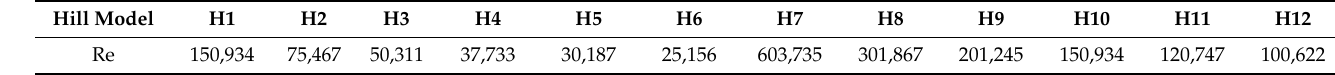
Table 3. Reynolds numbers for hill models ( V jet = 12 m/s).